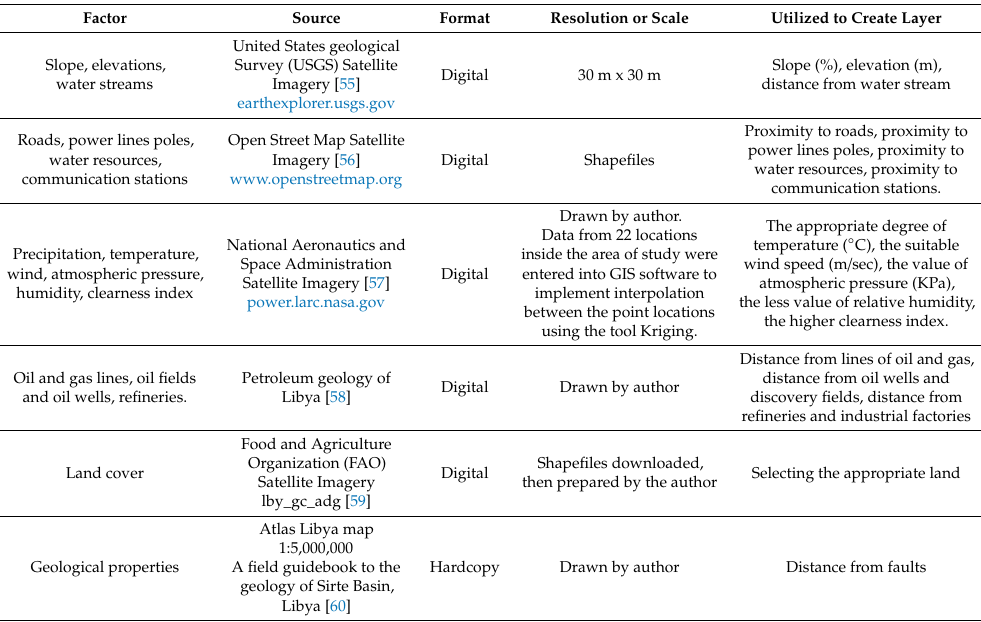
Table 2. Criteria used, sources, format and scale / resolution